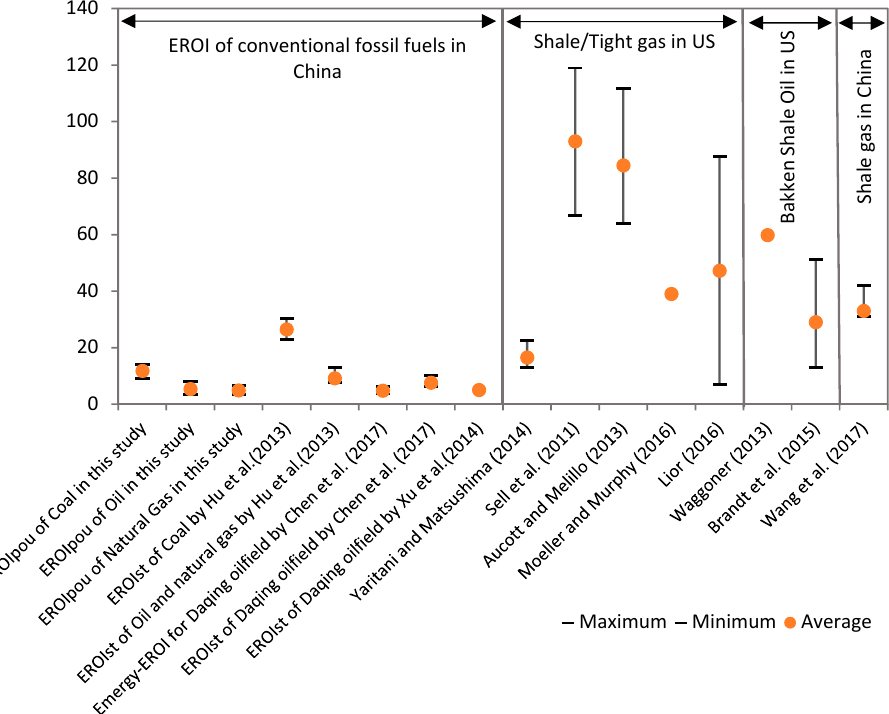
Figure 6. Comparison of EROI POU with present EROI studies.